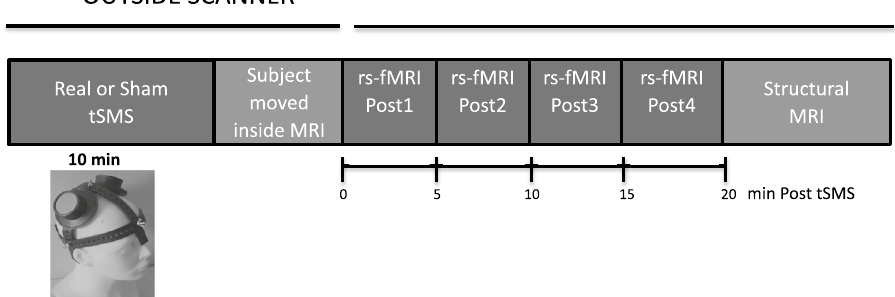
Figure 1. Experimental setup. All subjects underwent rs-fMRI after 10 min M1 real or sham tSMS. Rs-fMRI measurements were conducted in four blocks after tSMS application (out of scanner). The last rs-fMRI